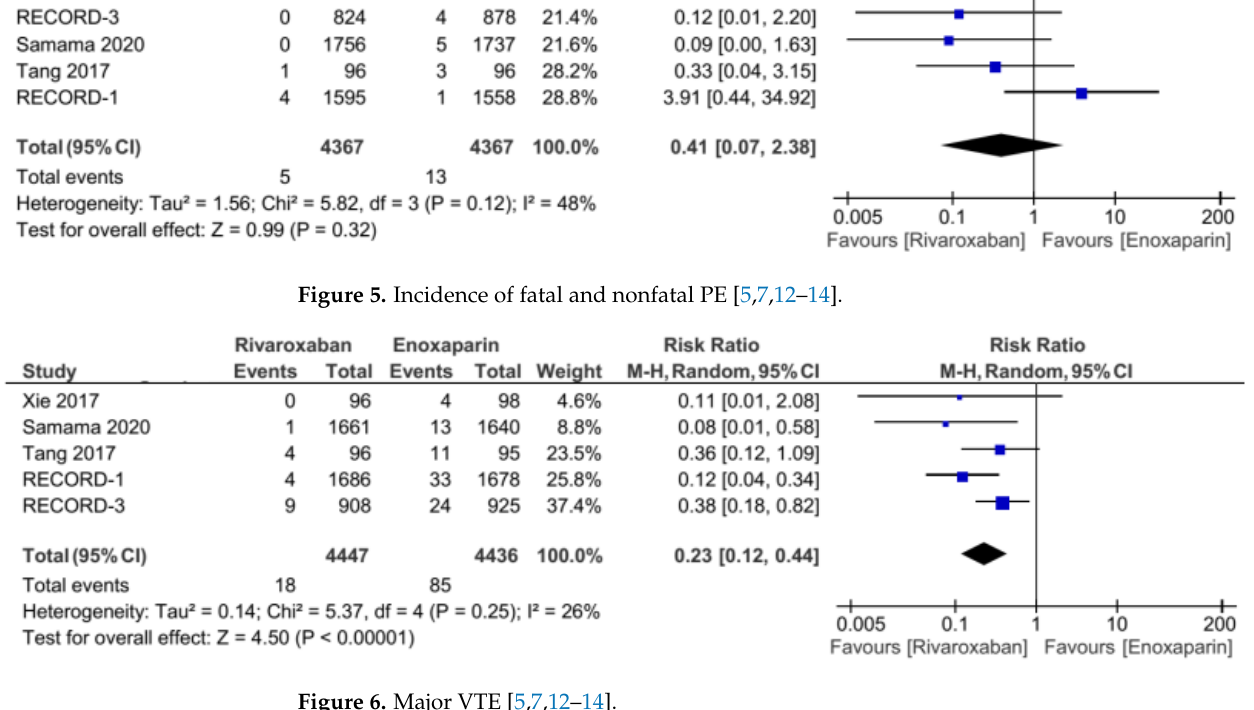
Figure 6. Major VTE [5,7,12 – 14].